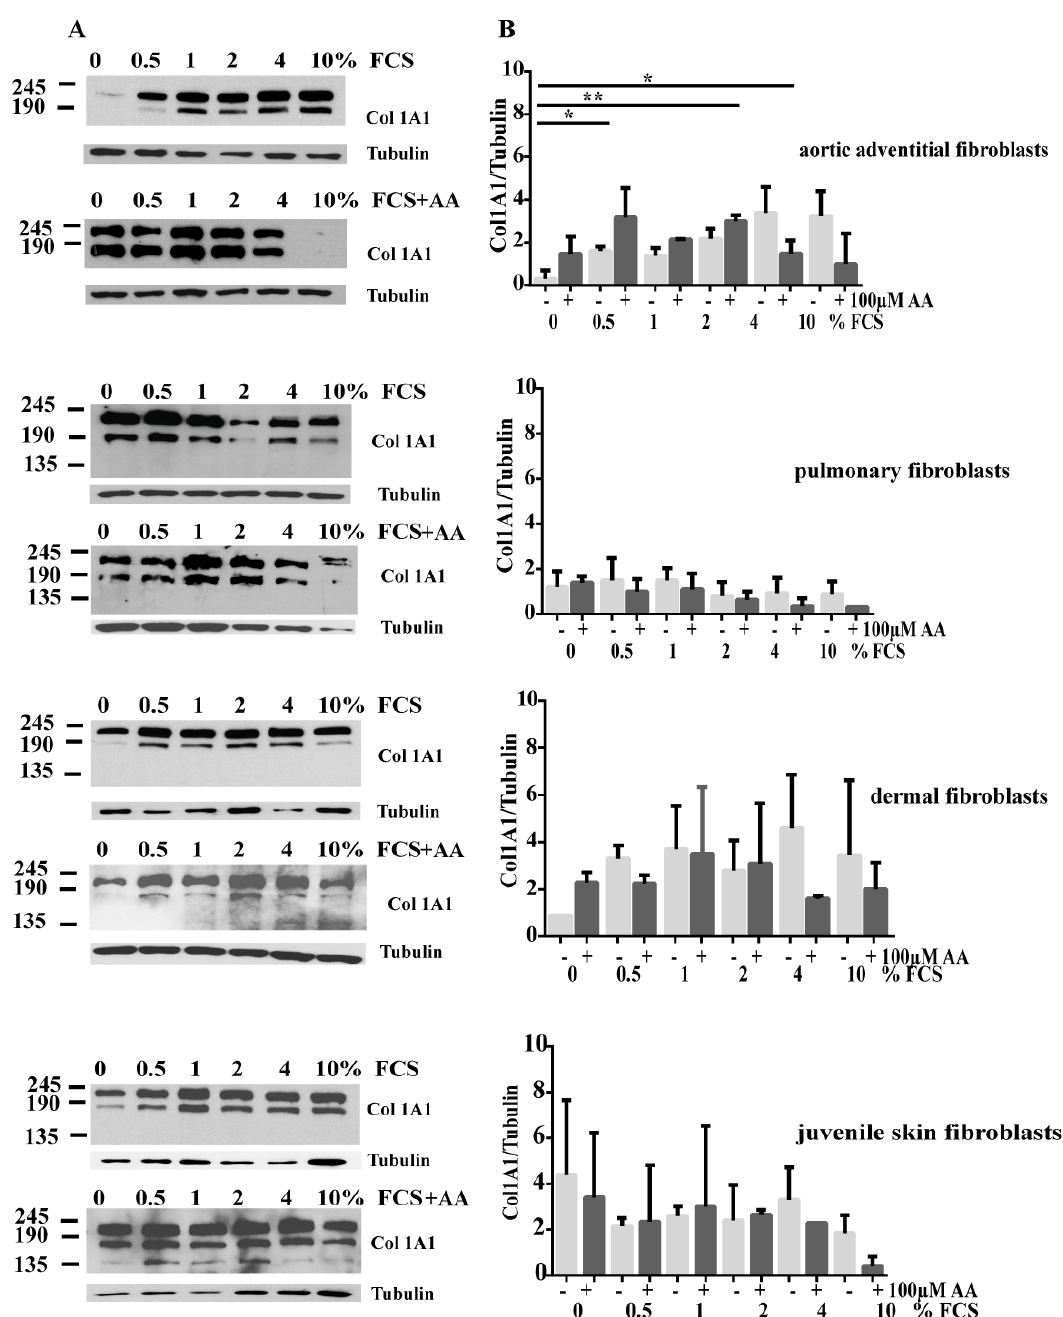
Figure 6. Procollagen I accumulates with increasing amounts of FCS in AoAF and skin fibroblasts, but is secreted after addition of AA. ( A ) Procollagen I (Col 1A1) expression after incubation with different amounts of FCS or without FCS is demonstrated in immunoblots. Tubulin is demonstrated as loading control. ( B ) Procollagen I expression in the presence of AA and with different amounts of FCS is demonstrated in immunoblots.